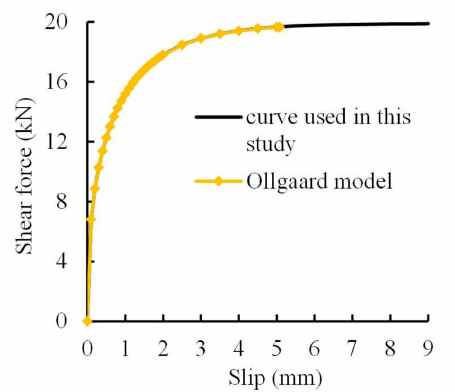
Figure 15. Shear force-slip curves for studs used in this study and proposed by Ollgaard [30].